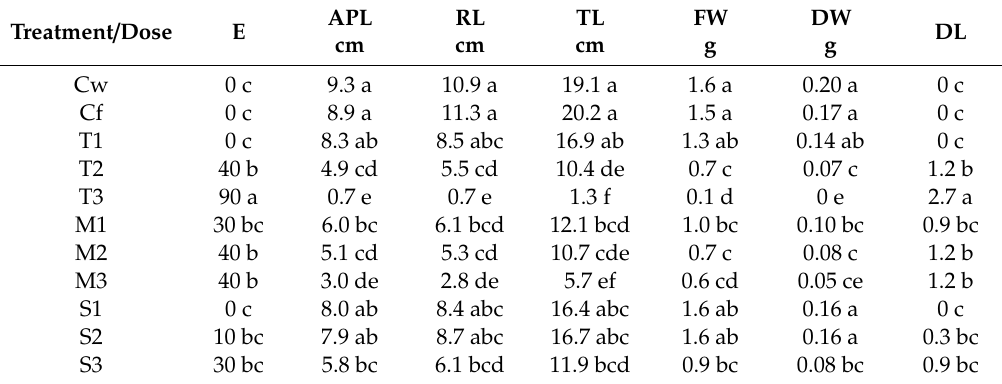
Table 3. E ff ects of T. capitata (T1, T2 and T3 are 4, 8 and 12 µ L mL − 1 dose of essential oil), M. piperita (M1, M2 and M3 are 12, 16 and 20 µ L mL − 1 dose of application), and S. chamaecyparissus (S1, S2 and S3 are 12, 16 and 20 µ L mL − 1 dose of application) essential oils applied by irrigation against P. oleracea on the e ffi cacy (E), plant biometric variables [aerial part (APL), root (RL) and total length (TL), fresh (FW) and dry weights (DW)] and damage level (DL). Cw (only water, neither Fitoil nor EO application), Cf (0.03 µ L Fitoil g − 1 of soil, no EO application). The damage level (DL) was assessed developing a damage scale ranging from 0 (no damage) to 3 (death of the plant). The e ffi cacy (E) of a given EO was considered as its capacity to kill the plants and was assessed by attributing the value 0 if the plant was alive and 100 if the plant was dead. Both DL and E are dimensionless. Data are the arithmetic mean of 10